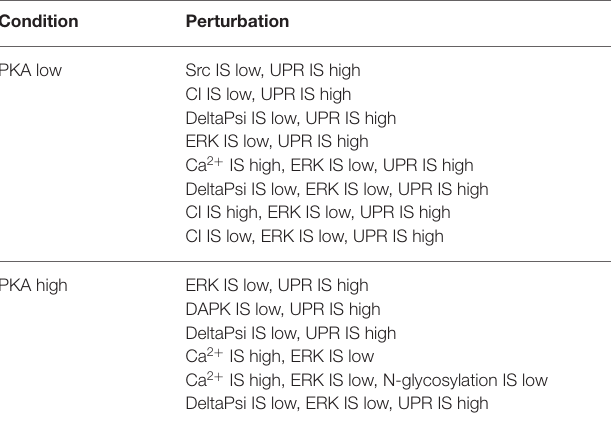
TABLE 2 | Optimal perturbations found by NSGA-II, using 3 objective functions, in both PKA high and low conditions.